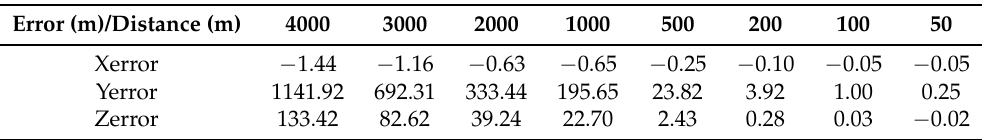
Table 1. Errors when the center extraction of the aircraft with 1-pixel disturbance, f = 100 mm and D = 10 m.